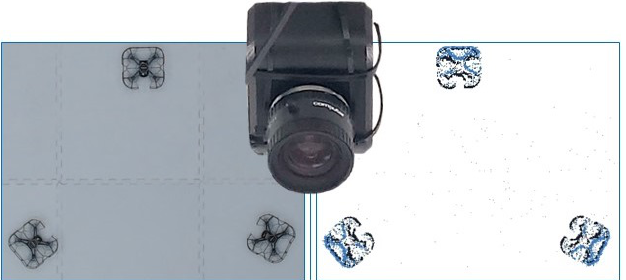
Figure 1. The event camera was mounted on the ceiling facing downward. Depicted here are 3 quadrotors positioned within the indoor arena, depicted in RGB ( left ) and event-based ( right ) camera streams.